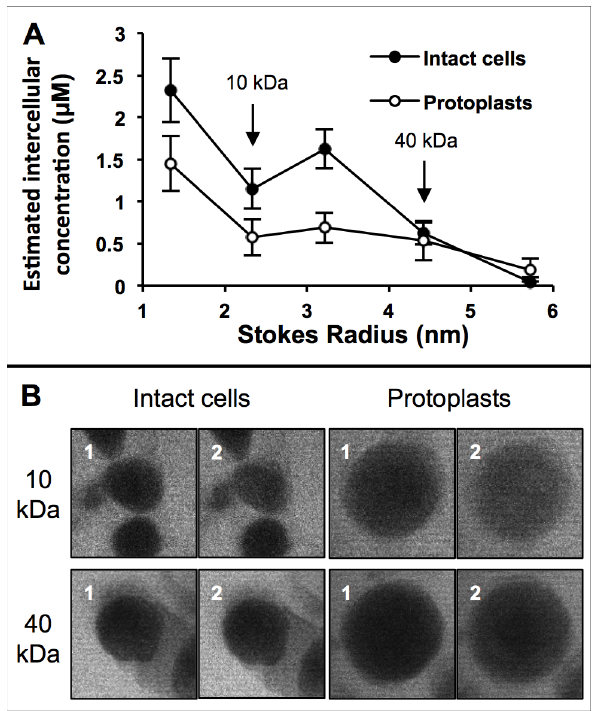
Figure 6. Effect of molecule size on cellular uptake. From looking at A, it can be seen that as the Stokes radius increases, the amount of dextran taken up by the cell decreases. The protoplasts take up less dextrans than the intact cells for Stokes radii smaller than 5 nm. Beyond 5 nm, the cellular uptake by the intact cells decreases to practically zero and more is taken up by the protoplasts. Data points shown are for n = 30 cells with error bars representing the S.E.M. B shows representative images (those depicting uptake most comparable to the average uptake) of intact cells and protoplasts before (1) and 3 mins after (2) photoporation in the presence of small and large dextrans. The larger dextrans show less (though still visible) entry into the cell than the smaller